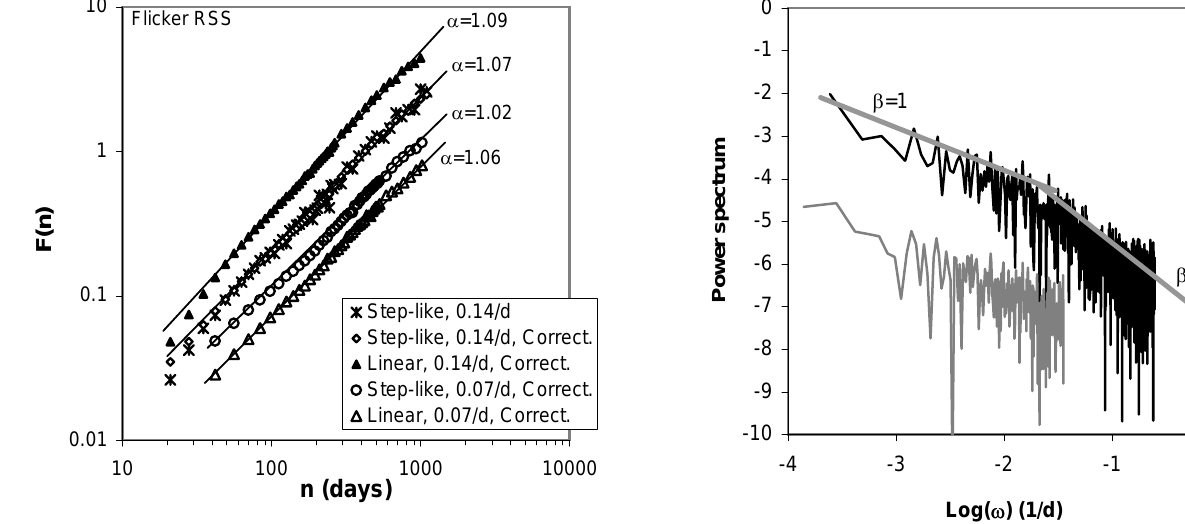
clarity. This procedure was repeated in the following figures when-